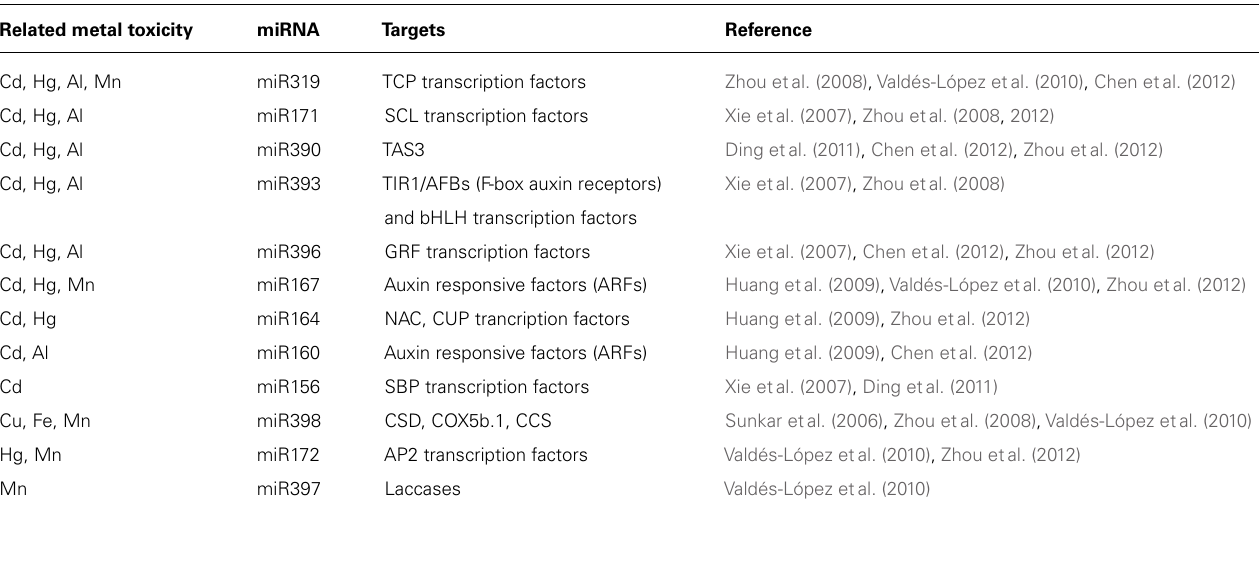
Table 1 | Metal toxicity-responsive